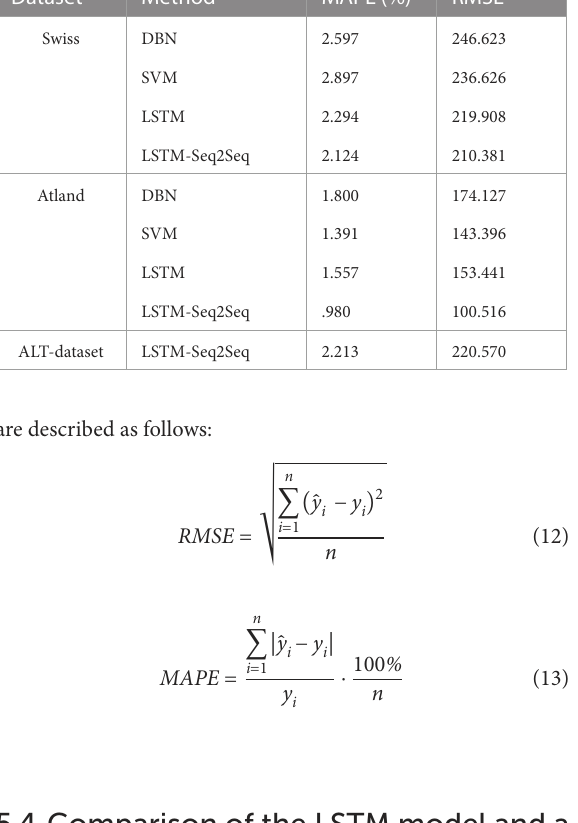
TABLE2 ExperimentalresultsofDBN,SVM,LSTMandLSTM-Seq2Seq.